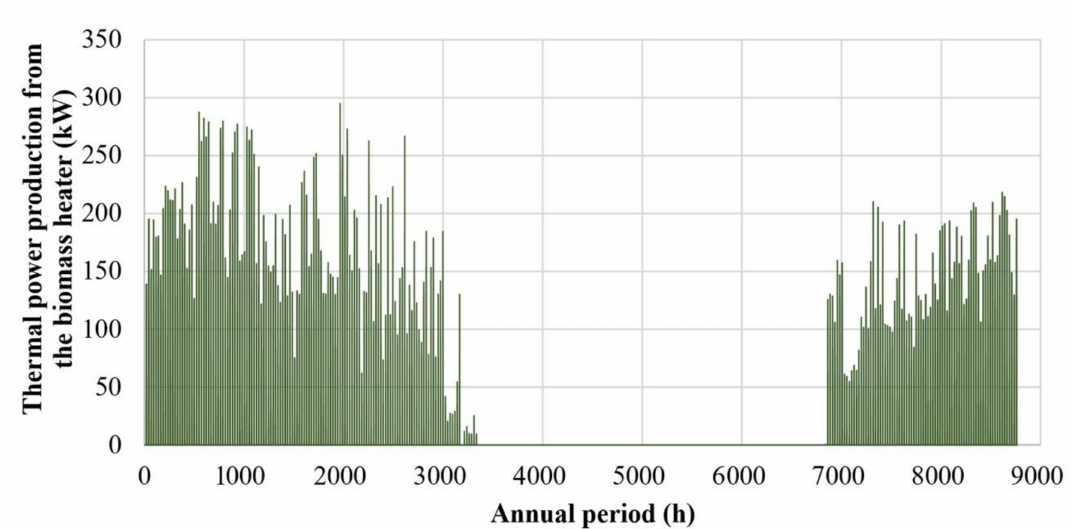
Figure 19. Annual fluctuation of the thermal power production from the biomass heater.